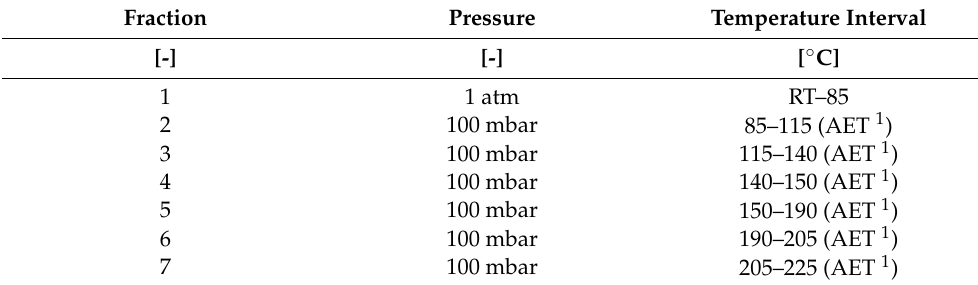
Table 1. Fractional distillation operating